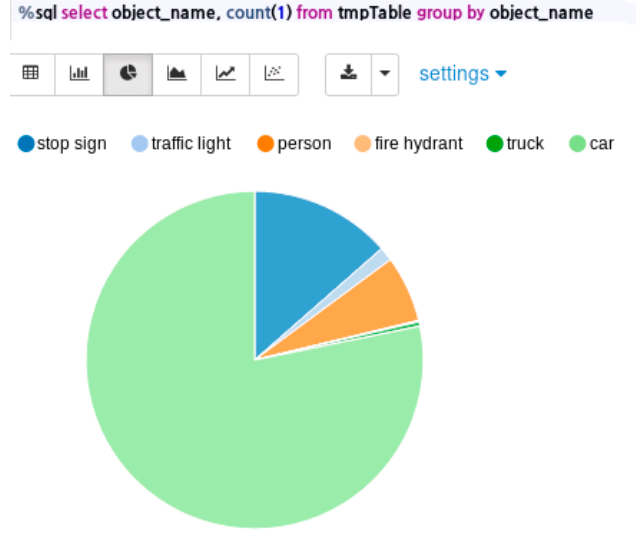
Figure 13. Zeppelin-based data visualization.